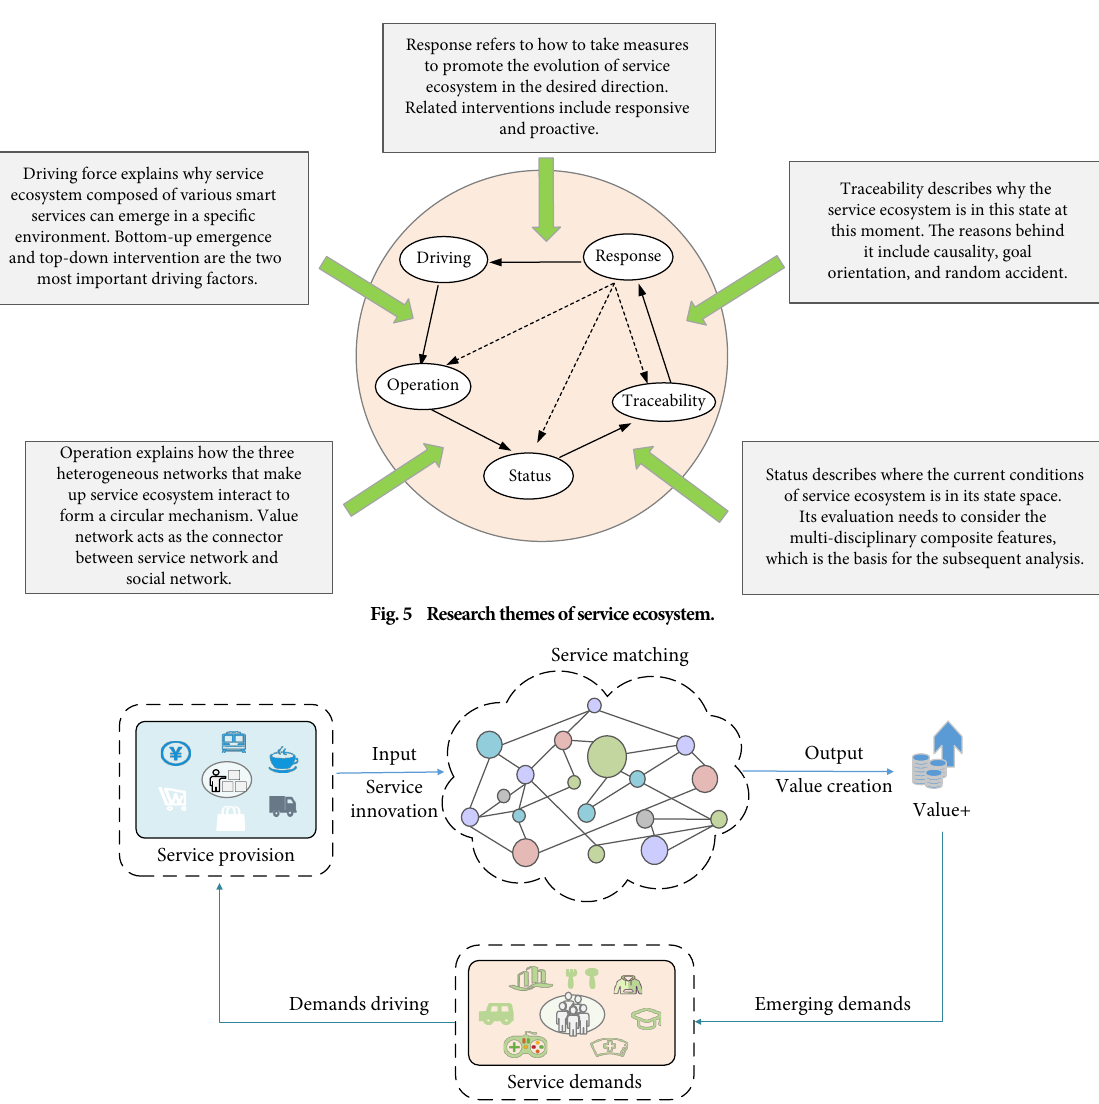
Fig. 6 Driving force of the service